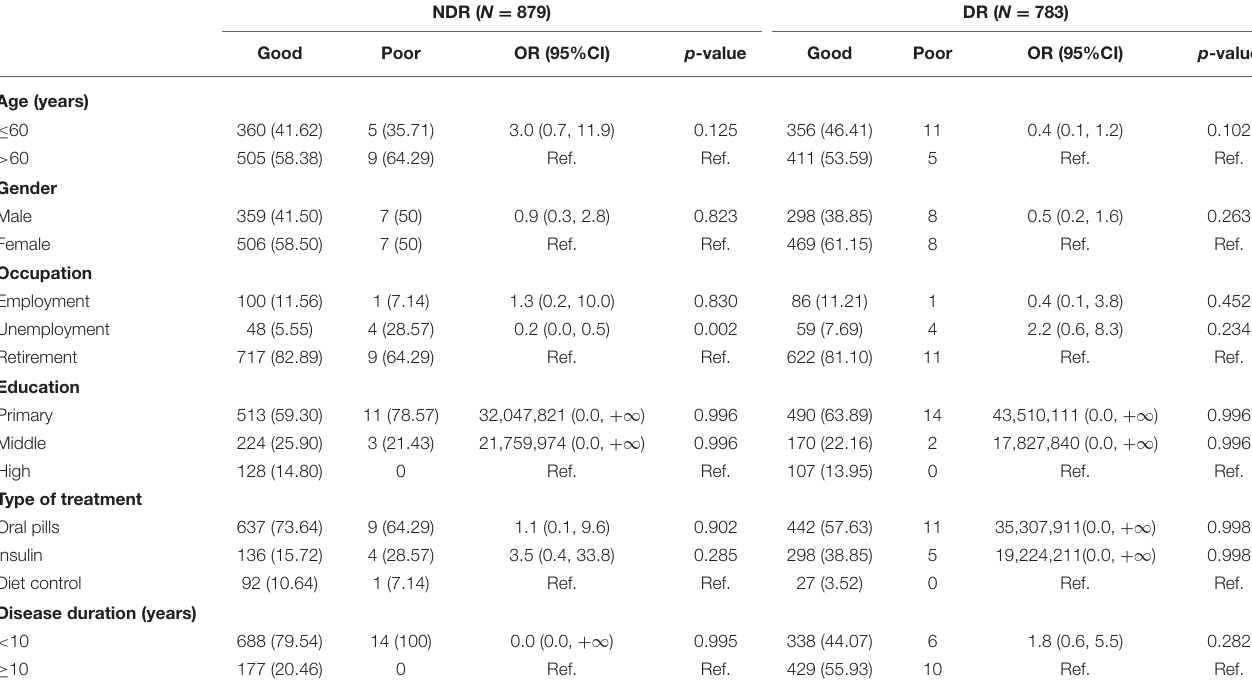
TABLE 3 | Multivariate logistic regression of good attitude in NDR and